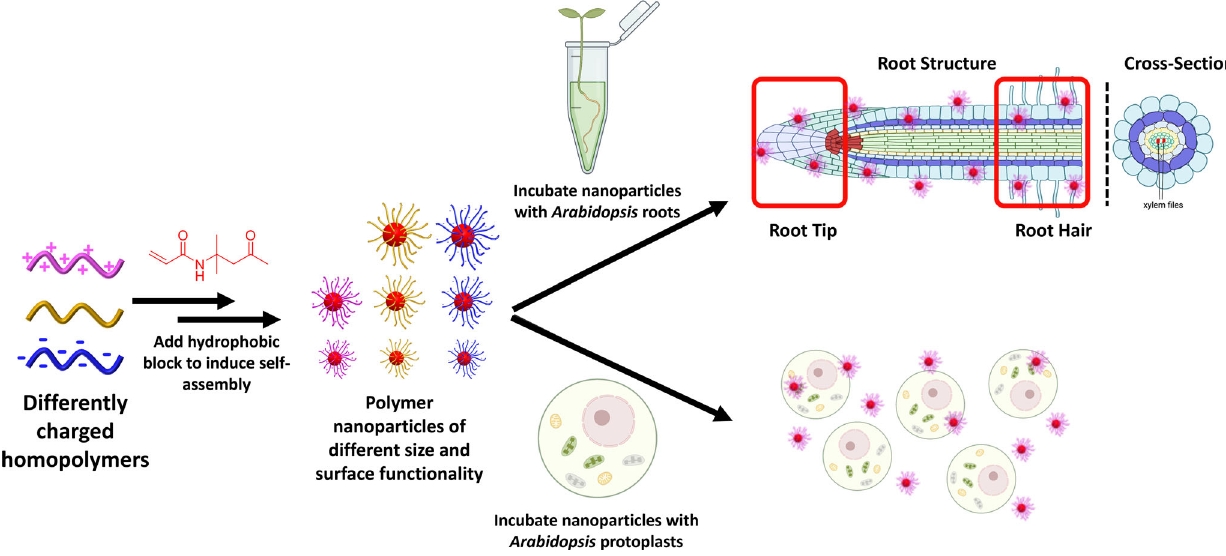
Fig. 1 | Synthesis of polymeric nanoparticles and subsequent uptake pathways explored. The charges associated with each class of nanoparticle are colour coded throughout the manuscript: magenta=positively charged; gold=neutral; blue=negatively charged. This fi gure was created with